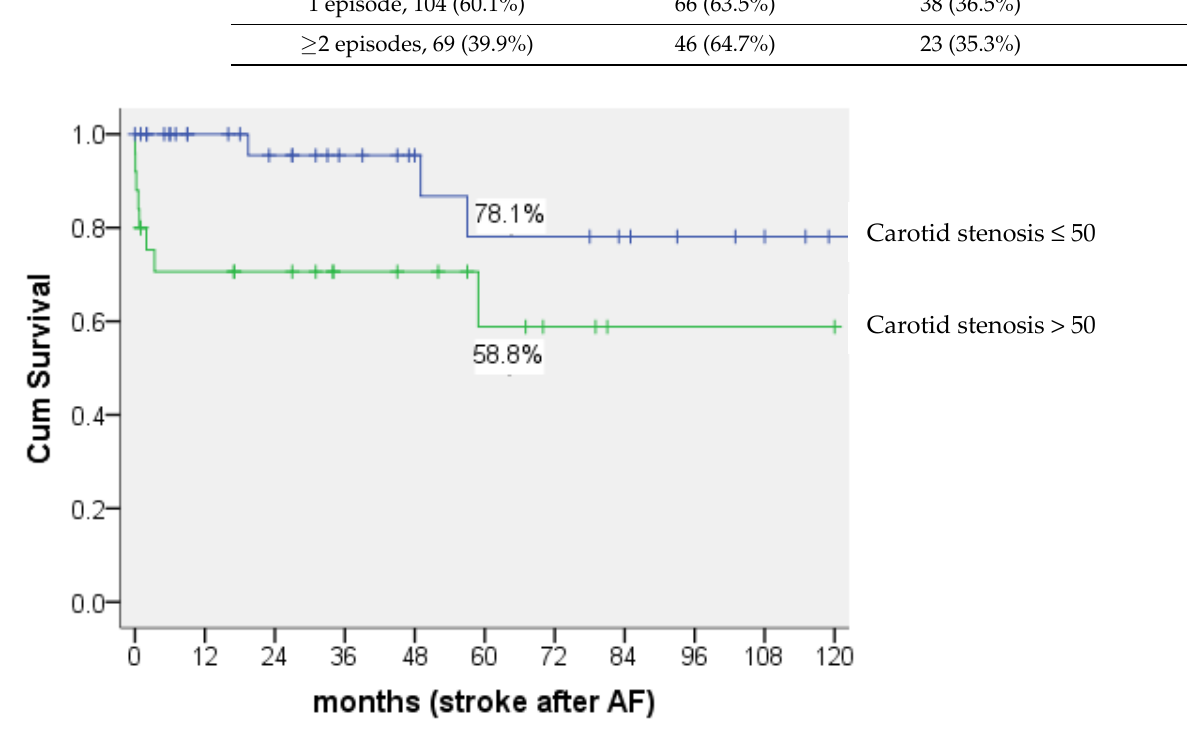
Figure 3. Kaplan-Meier curves showing the survival probability. AF: amaurosis fugax. The average time to develop stroke after AF was 131.1 ± 12.5 months in patients with carotid stenosis ≤ 50%, compared with 77.8 ± 12.2 months in patients with carotid stenosis >50%.